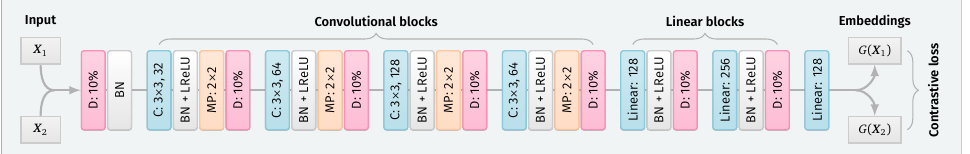
Figure 2. The architecture of the embedding model. Layer types denoted as: D—dropout, BN—batch normalisation, C—convolutional, MP—max-pooling, LReLU—LeakyReLU. Both the Siamese and prototypical models use the same embedder architecture, albeit with different loss functions and input